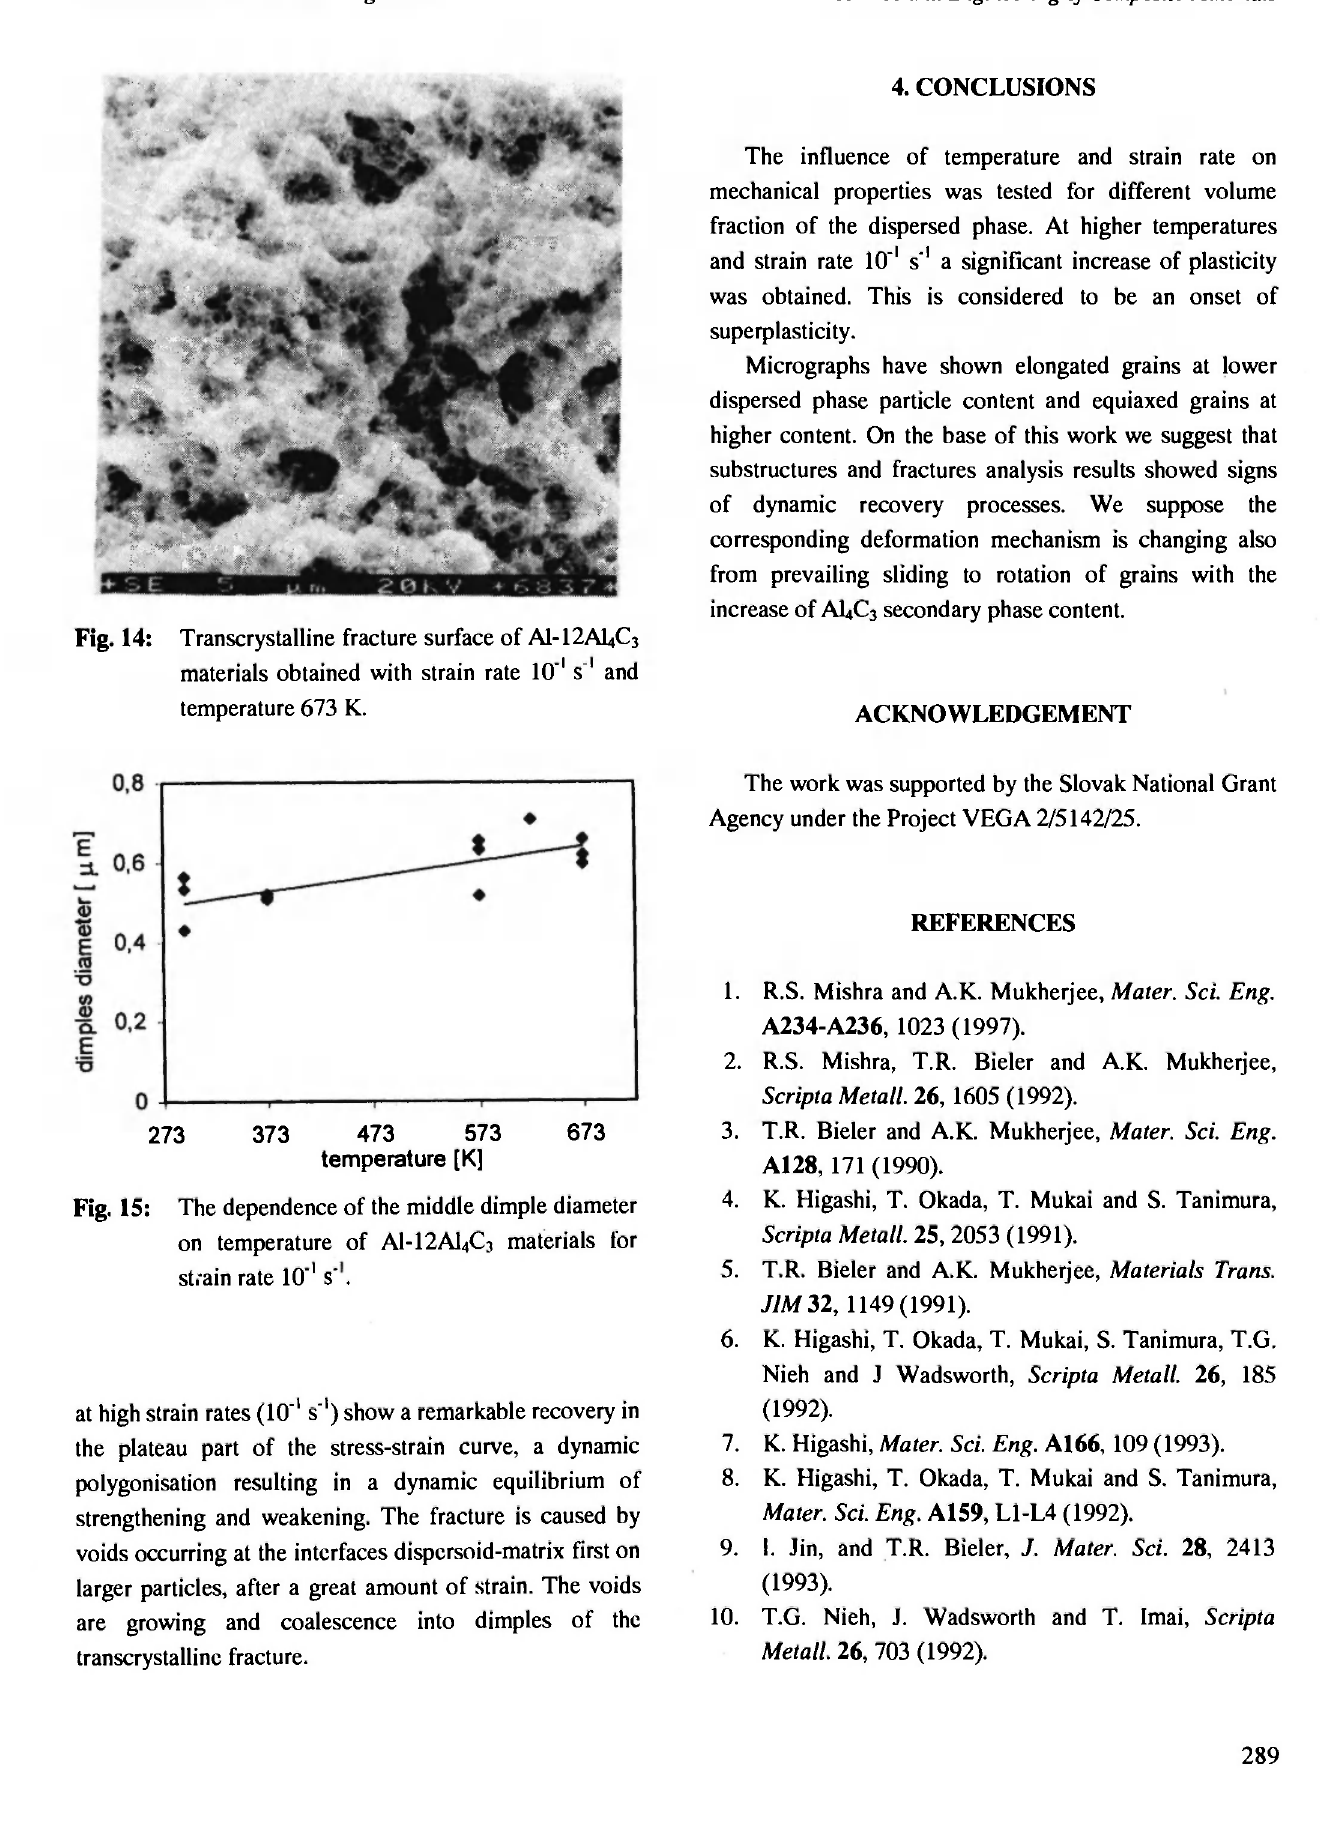
at high strain rates (10"' s" 1 ) show a remarkable recovery in the plateau part of the stress-strain curve, a dynamic polygonisation resulting in a dynamic equilibrium of strengthening and weakening. The fracture is caused by voids occurring at the interfaces dispersoid-matrix first on larger particles, after a great amount of strain. The voids are growing and coalescence into dimples of the transcrystalline